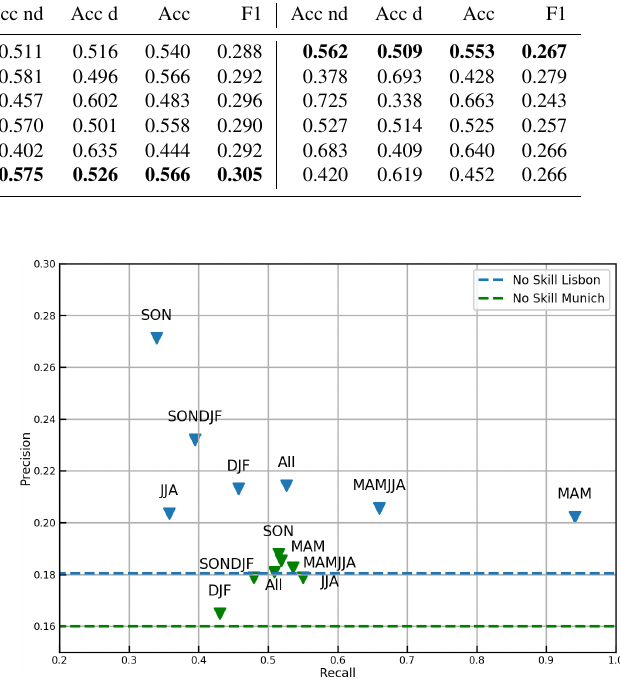
Table 5. Performance of models for the Lisbon and Munich domains for different variations in architecture on the test dataset. Acc nd refers to the accuracy of the non-drought class and Acc d to the accuracy of the drought class. The sixth model architecture is chosen for subsequent analysis for Lisbon and first for Munich (bold) due to an accuracy of at least 0.5 of both classes and a higher performance with regards to the F1 score. Neurons Architecture